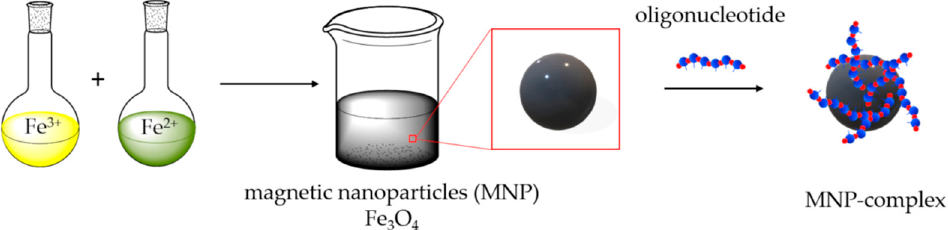
Figure 1. Representation of magnetic nanoparticles (MNPs) synthesis and its surface modification by oligonucleotides.